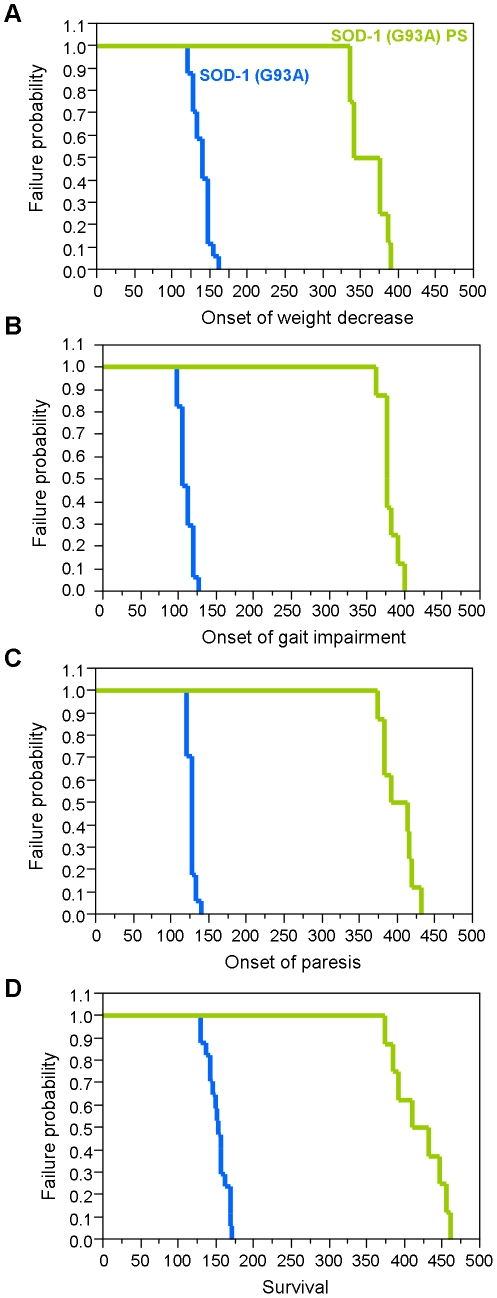
Timed data for onset and survival.Given are parameters for disease onset (A-C), and survival (D) for the SOD-1 (G93A) (n = 17) and SOD-1 (G93A)PS mice (n = 8). (A) Onset of weight decrease was defined as a drop of 5% of the mouse maximal weight. (B) First manifestation of symptoms that are linked to gait impairment in terms of limbs coordination and overall stance, and (C) time to first manifestation of paresis. (D) End point of the disease, defined as the inability of the mouse to right itself within 30 seconds.